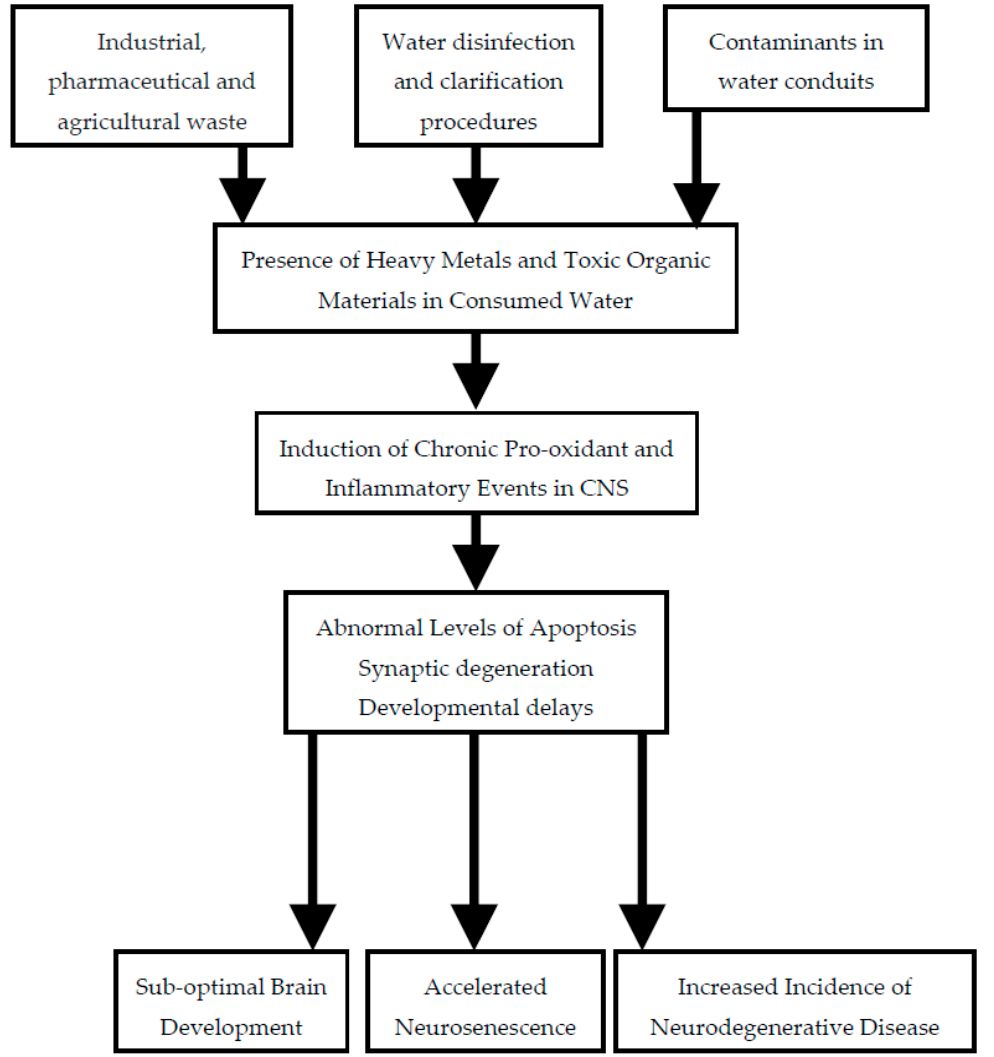
Figure 1. Sources of neurotoxic agents in drinking water and their potential consequences. CNS: central nervous system.